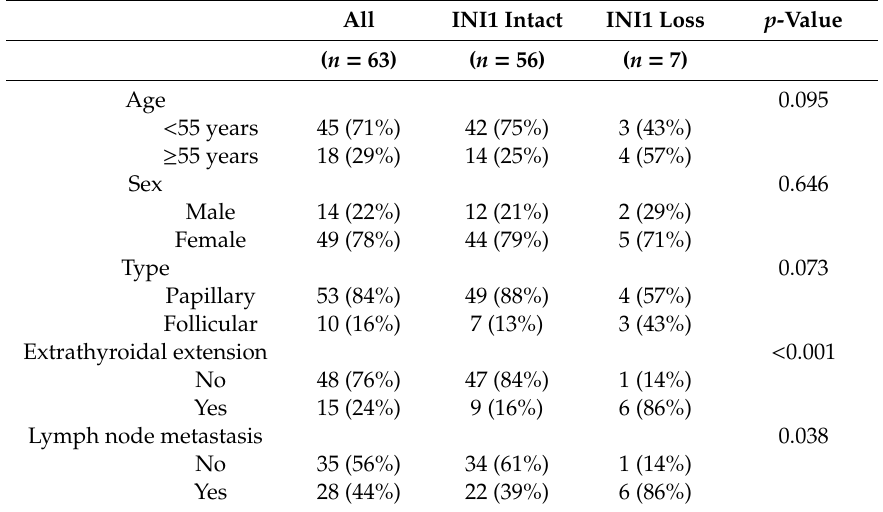
Table 1. Associations between clinicopathological features and the immunohistochemical expression of integrase interactor 1 (INI1) in di ff erentiated thyroid cancer.